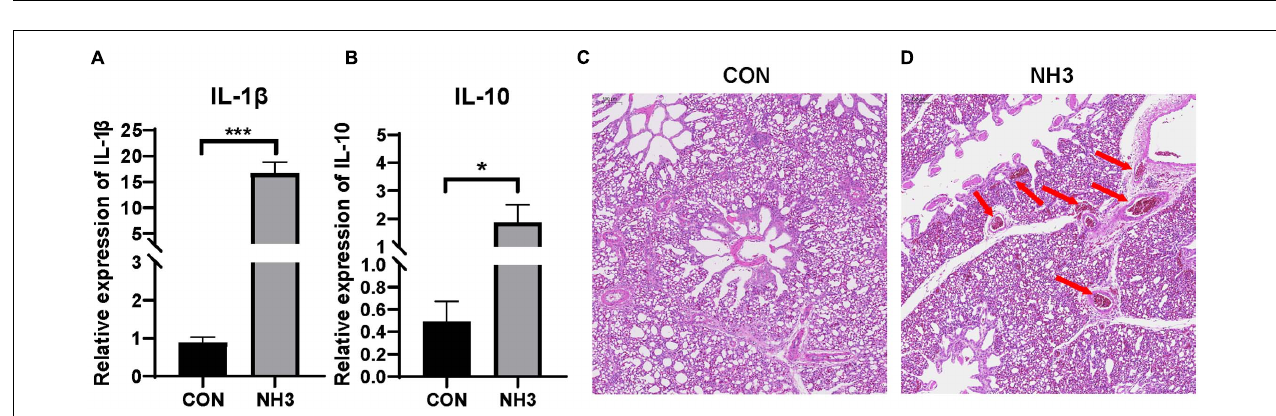
FIGURE 5 | Function of broiler lung microbiota in different age groups. (A) Principal component analysis (PCA) plotting for the predicted microbial functions among the five age groups according to the functional annotation and abundance of level 2 Kyoto Encyclopedia of Genes and Genomes (KEGG) pathways using Tax4Fun ( p = 0.001). (B) Heatmap of the different functions identified from the level 2 analysis.